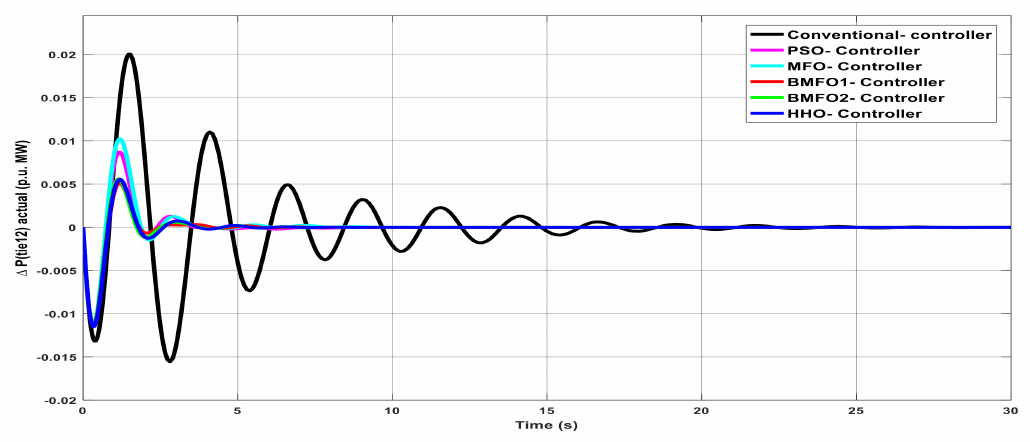
Figure 17. Deviation in actual tie-line power flow with various controllers under contract violation case.